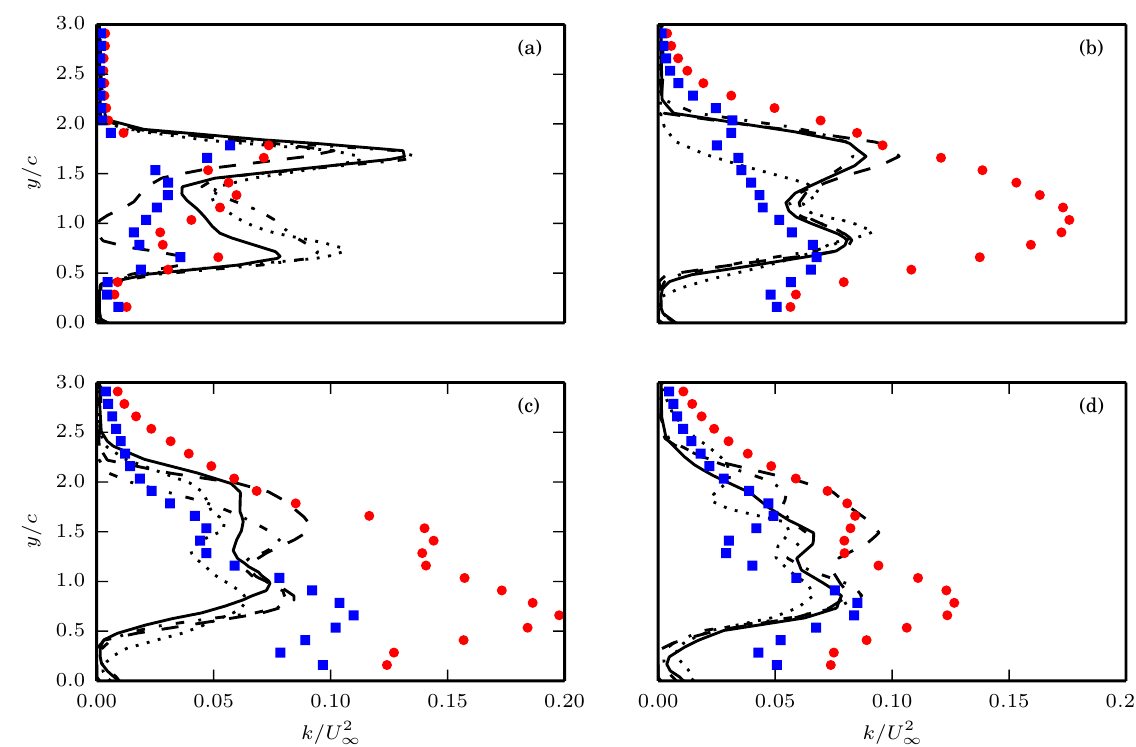
Figure 6. Turbulent kinetic energy k profiles at ( a ) x / c = 1.5, ( b ) x / c = 3.5, ( c ) x / c = 5.5, and ( d ) x / c = 7.5. Lines refers to numerical results for the different turbulent models: k - (cid:101) ( ); SST k - ω ( ); transition SST ( ); and RSM ( ). Experimental k is shown as ( ), while u (cid:48) 2 is referred as ( ). The vertical dimension is normalised with respect to the panel chord length c . The energy magnitude is normalised with respect to the power square of the inlet free-stream velocity measured in the wind